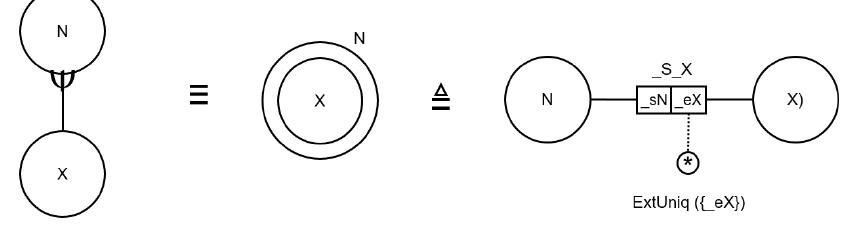
Figure 6. The definition of set type S = Set ( N , X